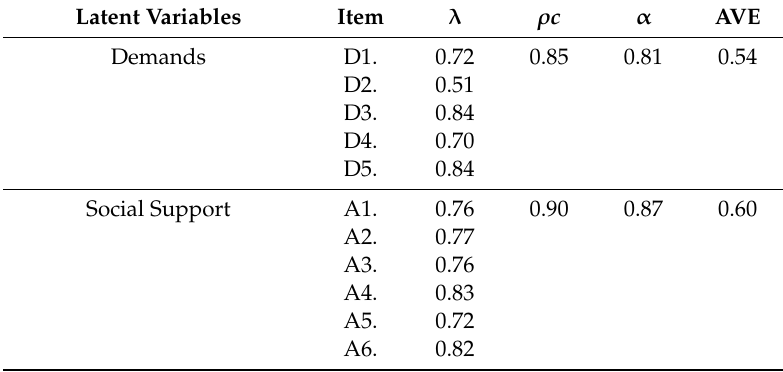
Table 3. Outer model: Reliability and convergent validity